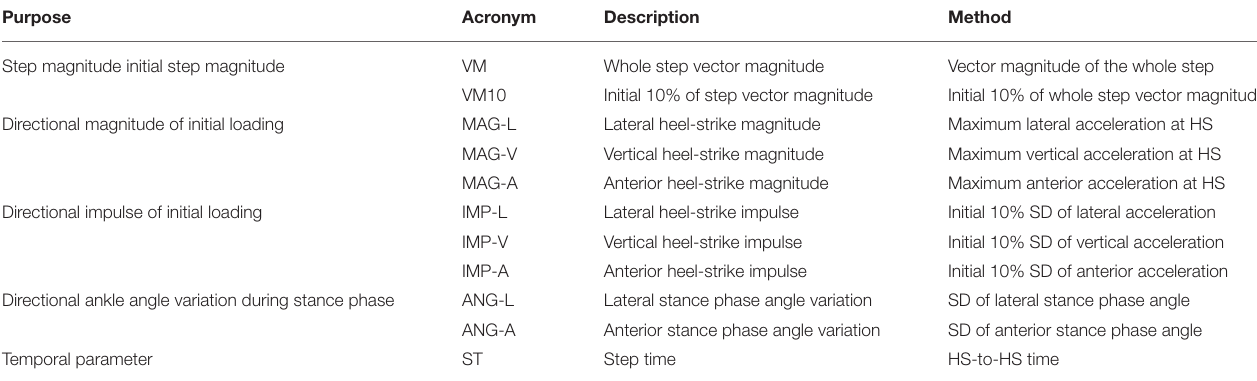
TABLE 1 | Inertial gait variable properties.